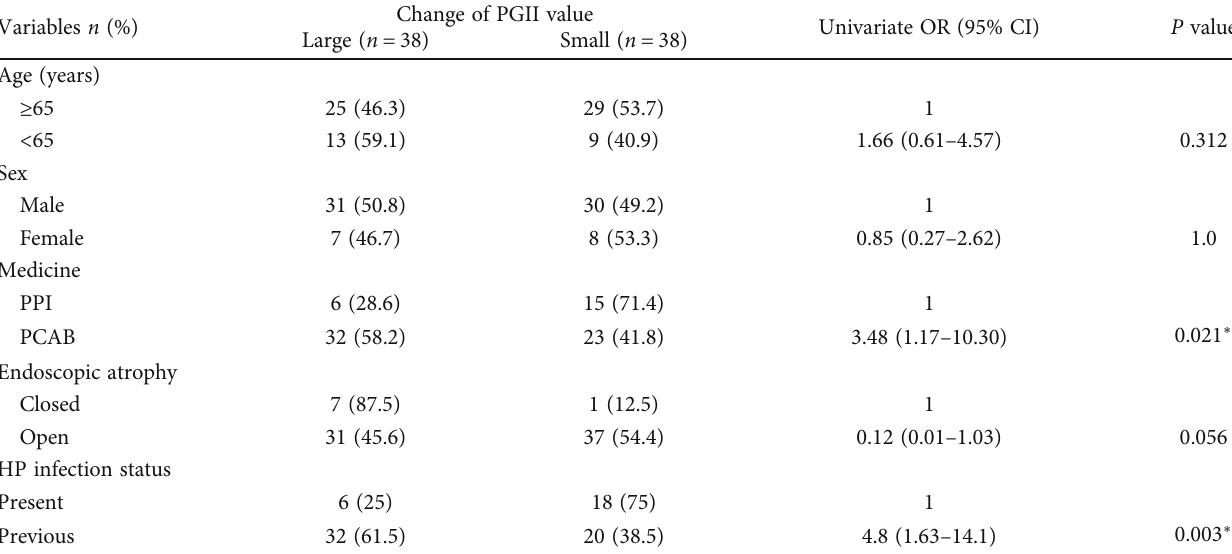
Table 5: Univariate analysis of the host factors that contribute to PGII level